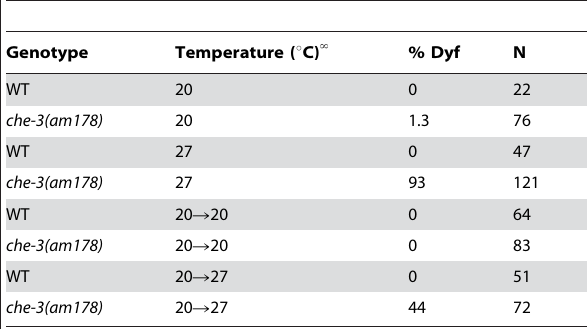
Table 2. The che-3(am178) mutation caused temperature- sensitive defects in DiO staining of amphid neurons.